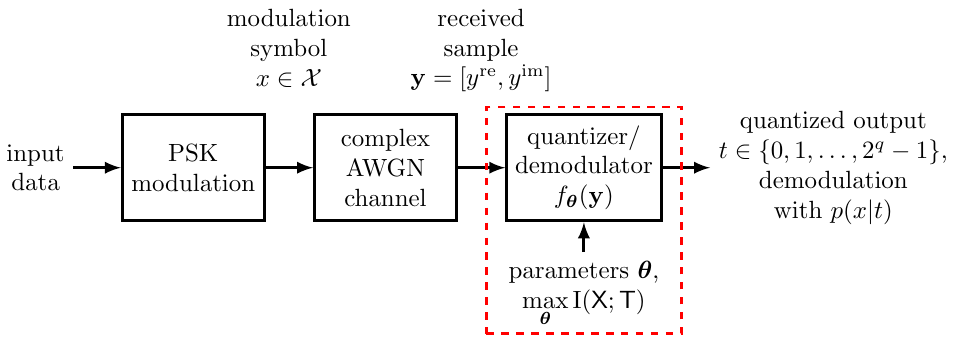
Figure 3. Exemplary application of a parametrized mapping t = f θ ( y ) for the quantization and demodulation of an AWGN channel output under PSK modulation. The system output t be highly informative about the transmitted modulation symbol x